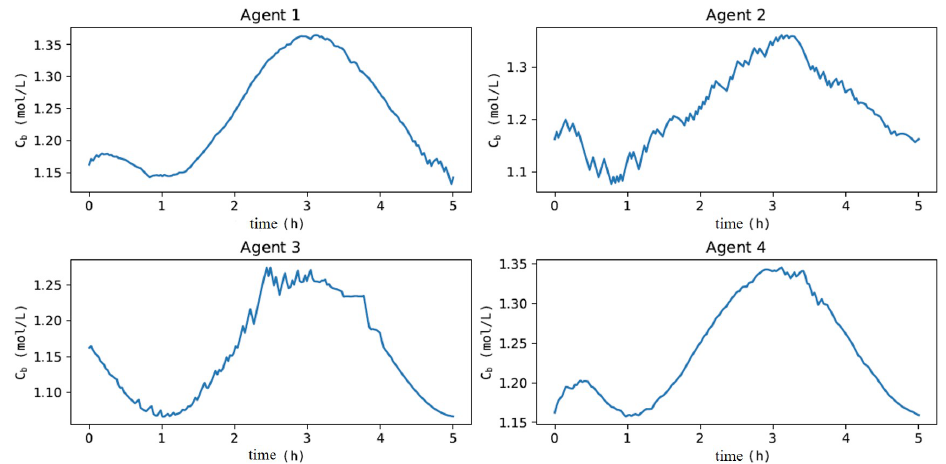
Figure 11. Dynamics of C b when subjected to process disturbances of Figure 10 over a 5 h control ex- periment.